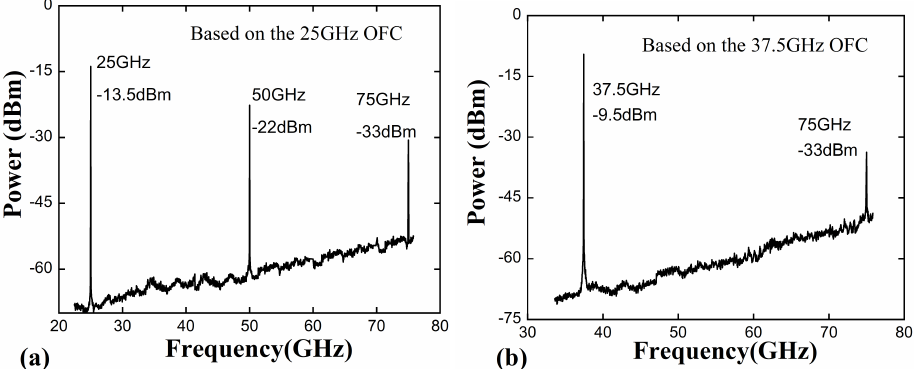
Figure 4. Electrical spectra of the K-band and V-band at different intervals as measured from the MMW frequency synthesizer. ( a ) MMW generated from the 25 GHz OFC; ( b ) MMW generated from the 37.5 GHz OFC.